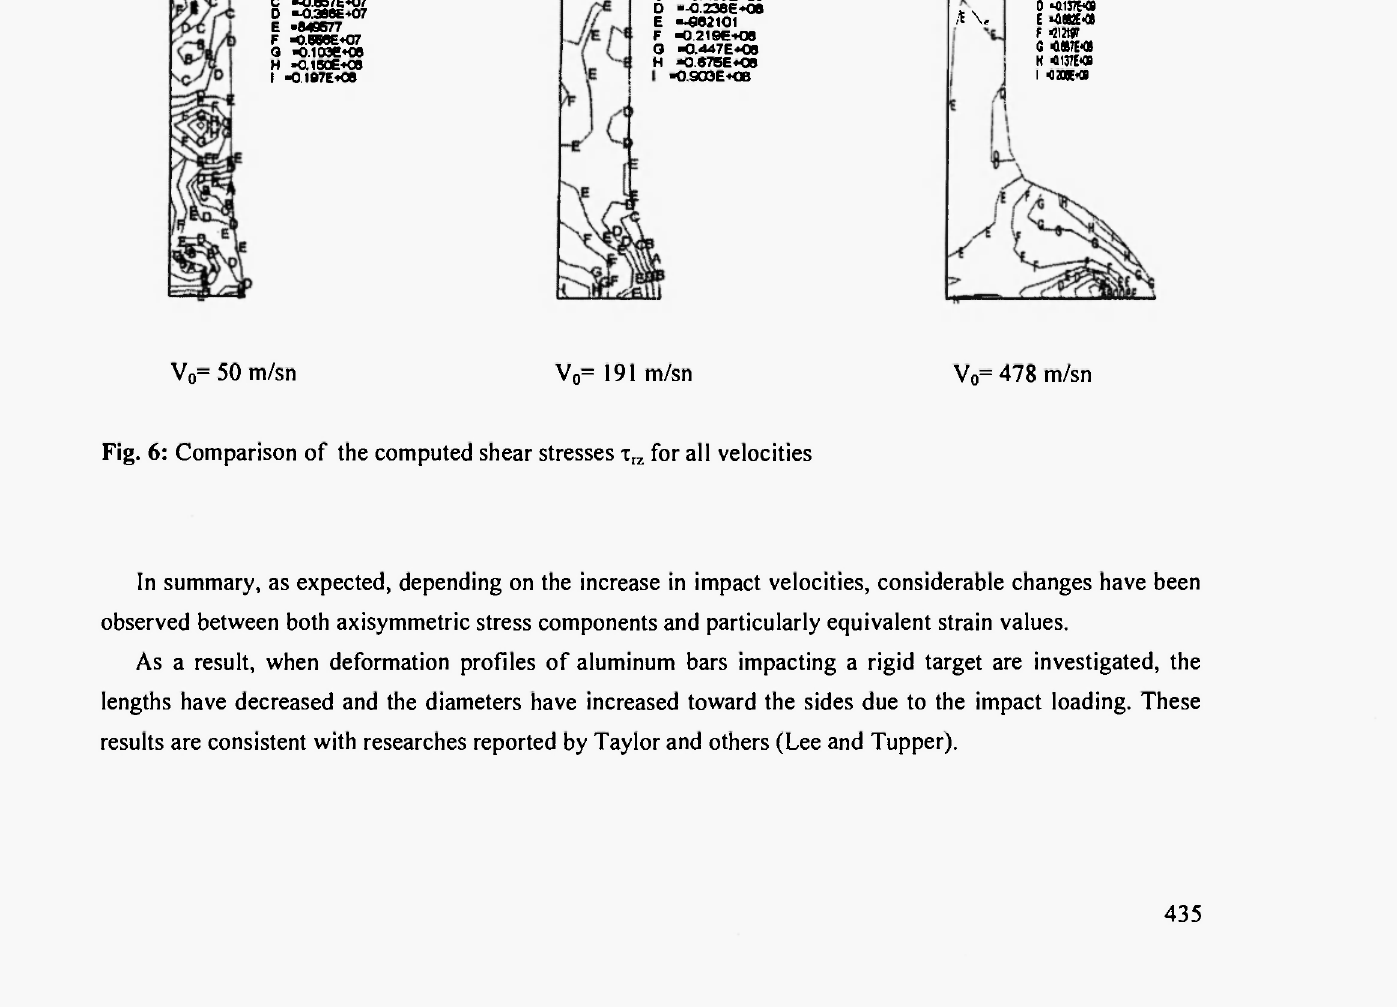
Fig. 6: Comparison of the computed shear stresses τ ΓΖ for all velocities